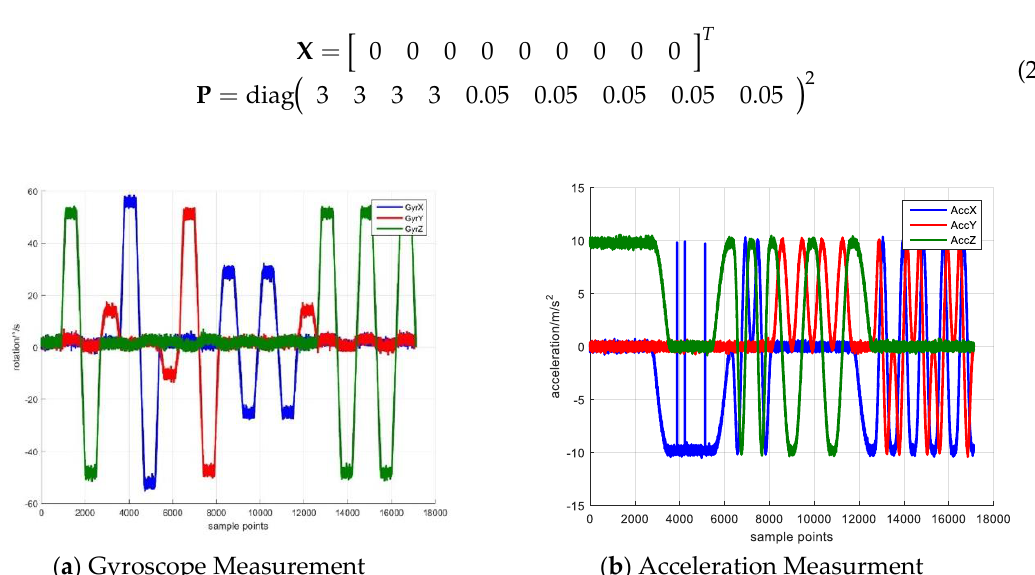
Figure 1. Simulated Inertial Sensor Measurement.